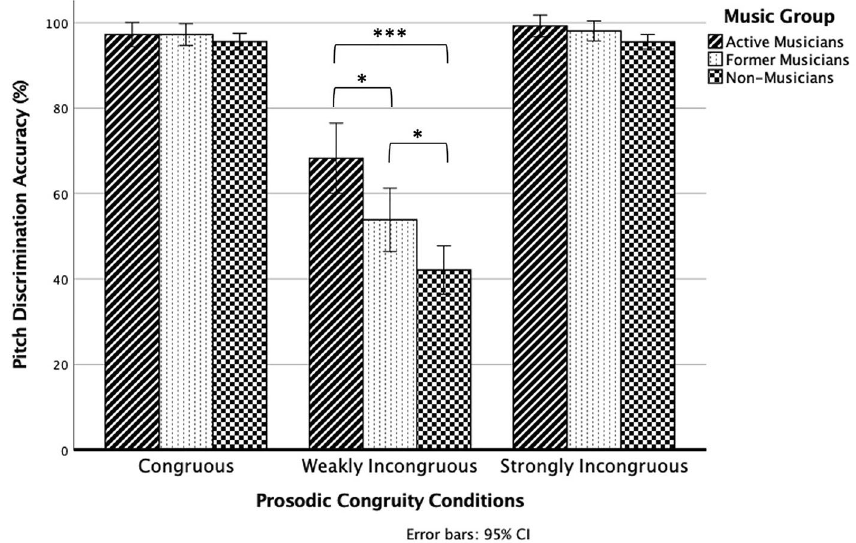
Figure 2. Pitch discrimination accuracy of active musicians, former musicians, and non-musicians in the three prosodic conditions. Error bars denote standard error. * p < 0.05, *** p < 0.001.